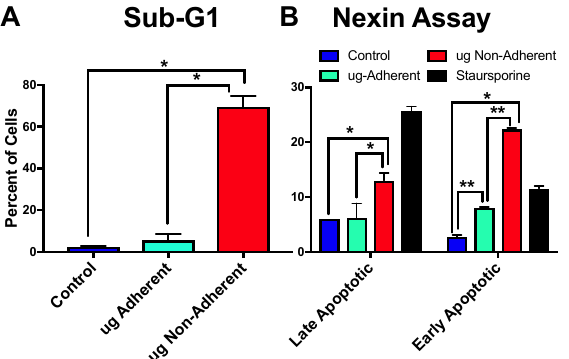
Figure 4. Levels of apoptosis as measured by sub-G1 apoptotic population of cells as defined by PI staining and flow cytometry ( A ), * p = 0.004. Early and late apoptosis as defined by the Nexin flow-based assay ( B ). Staursporine (black bar) was used as a positive control, * p ≤ 0.04, ** p = 0.0001.